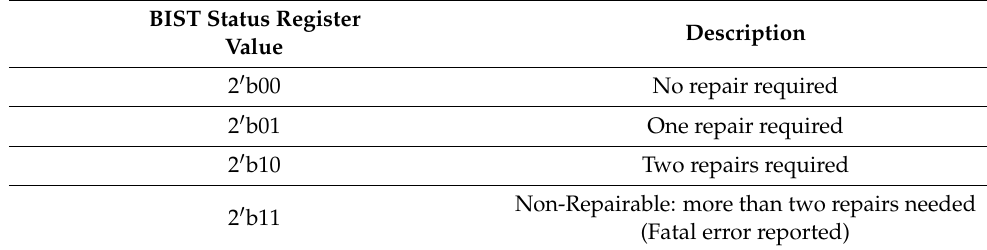
Table 1. Repair status register values of TSV